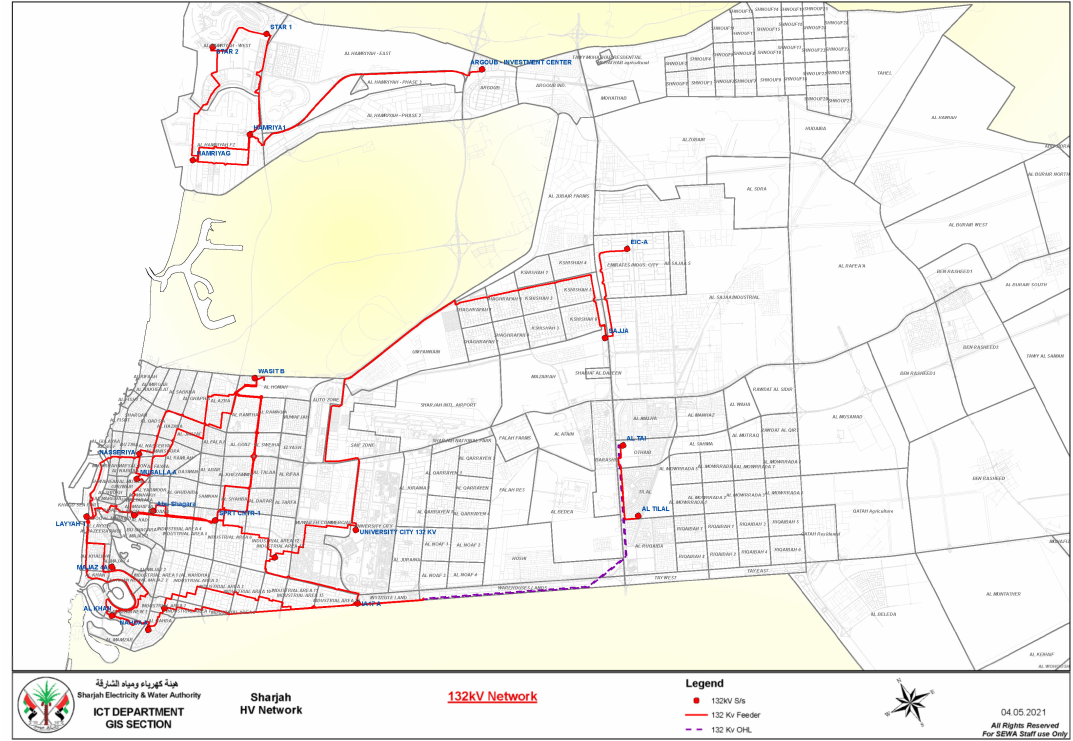
Figure 1. Map of Sharjah City and the power line feeder locations assessed in this